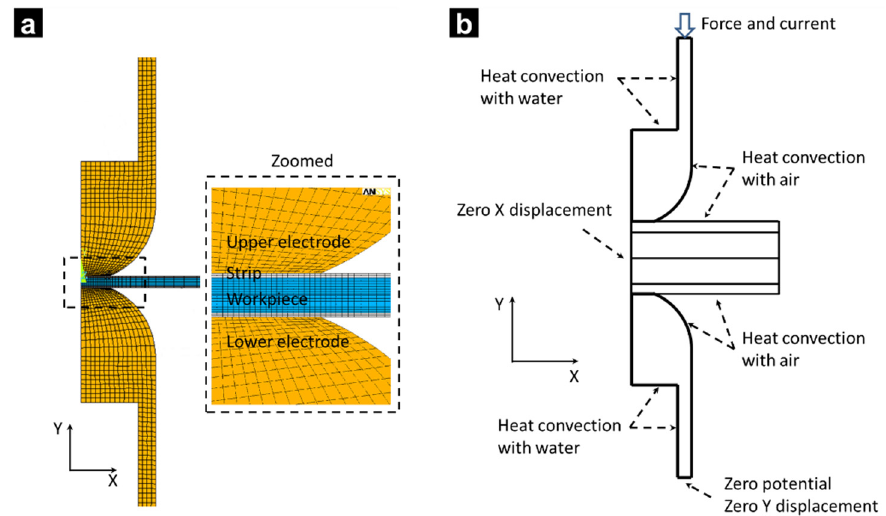
Figure 1. ( a ) Geometrical model and ( b ) boundary condition [4]. Reprinted with permission.